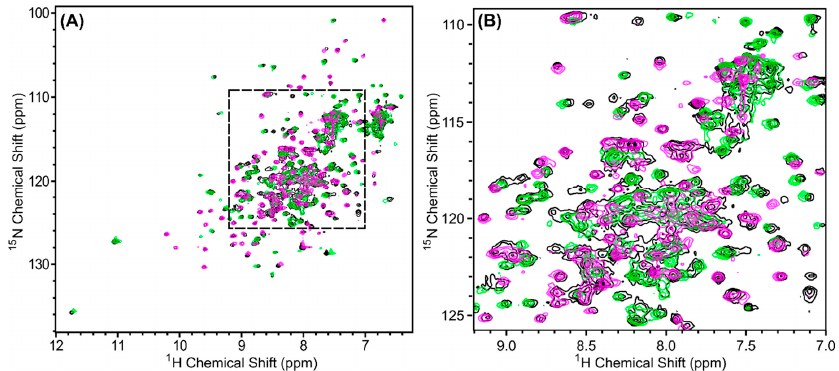
Figure 7. 1 H, 15 N-HSQC spectra of in vivo-associated 15 N-labeled Scc4:His 6 -Scc1 (black), renatured 15 N-Scc4:His 6 -Scc1 (pink), and renatured Scc4: 15 N-His 6 -Scc1 (green) overlaid to compare the peak positions and intensities. ( A ) The full spectra with a dashed box indicating the region expanded in ( B ). Over 97% of the peaks from the renatured complexes and the in vivo-associated complex overlap. The minor difference observed in ( B ) are discussed in Appendix C, Figure C1.